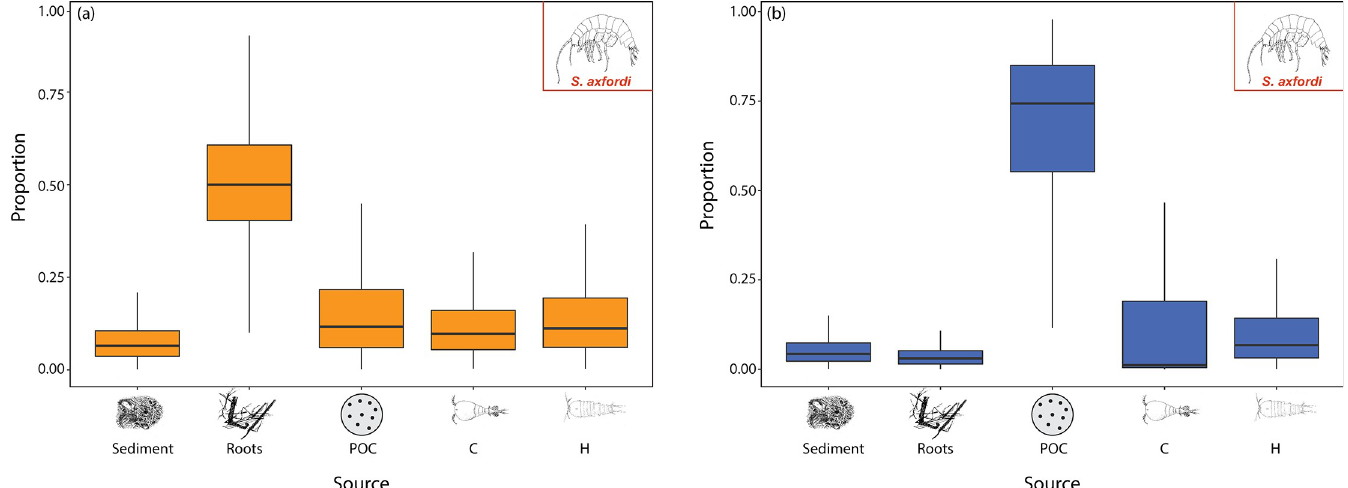
Fig 6. Modelled contributions to the diet of amphipod S . axfordi (AM1) under a) LR and b) HR conditions. POC: particulate organic carbon, C: Cyclopoida sp.; H: Harpacticoida sp. Medians and quartiles of each prey category are represented in the boxplot, see S3 Table for SIA δ 13 C and δ 15 N data. AM2 illustrated the same dietary preferences as AM1 under both rainfall conditions.